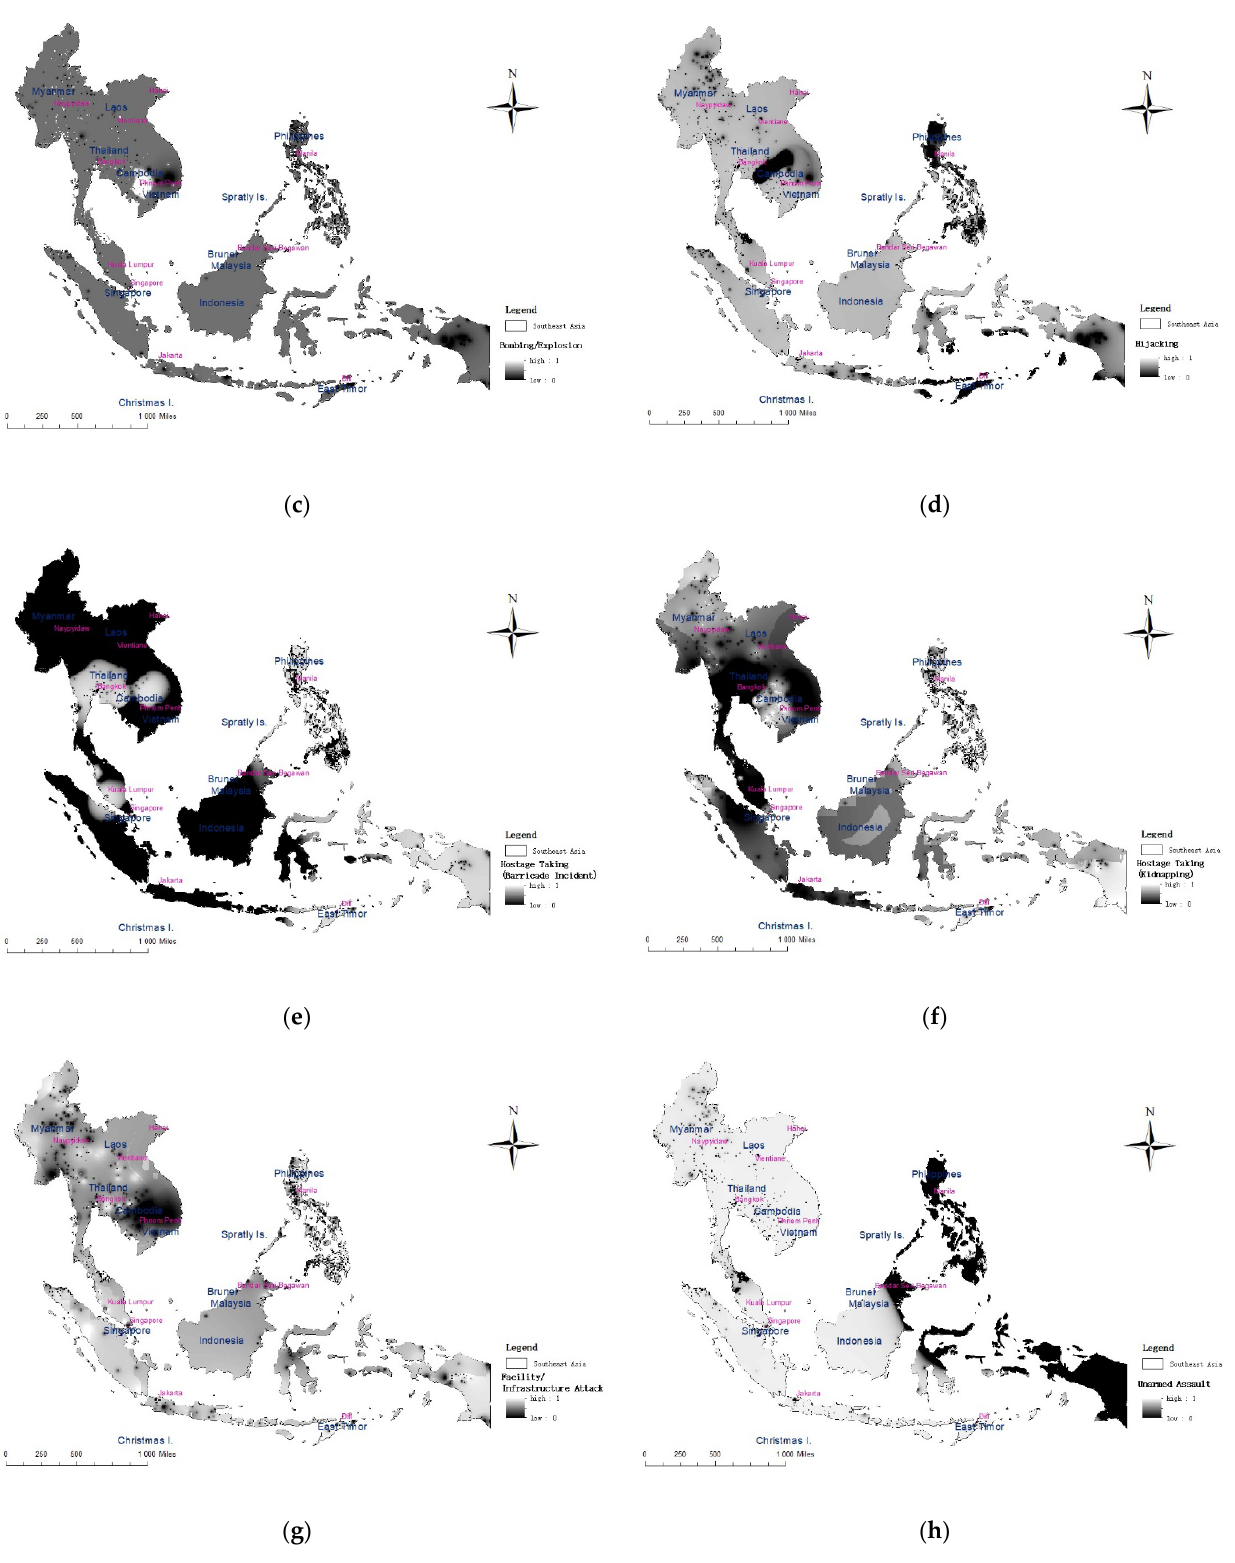
Figure 7. Risk assessment results of eight types of terrorist attacks in Southeast Asia. ( a ) Assassination; ( b ) Armed Assault; ( c ) Bombing/Explosion; ( d ) Hijacking; ( e ) Hostage Taking (Barricade Incident); ( f ) Hostage Taking (Kidnapping); ( g ) Facility/Infrastructure Attack; ( h ) Unarmed Assault.